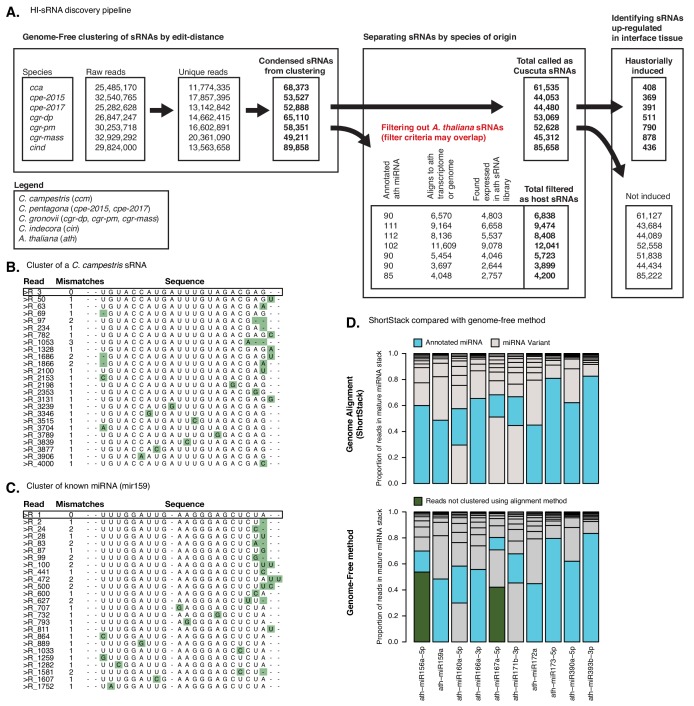
Genome-free HI-sRNA discovery pipeline.(A) Discovery of HI-sRNAs in Cuscuta isolates. Three major steps include condensing reads to representative sRNAs in a genome-free manner, filtering reads which could have originated from A. thaliana, and performing differential expression with DEseq2 to find reads up-regulated in the interface tissue (FDR < 0.1, null hypothesis: sRNA not differentially expressed). (B) Example of a C. campestris sRNA discovered by this method, with the top 25 constituent sRNA sequences ranked by expression. Highest expressed read is deemed as the representative sRNA sequence and is shown with black box. Green boxes show variations from representative sequences with total distance shown to left. (C) Same as B but with a known miRNA, showing similar variation to the novel sRNA in B. (D) Comparing the proportion of reads present in annotated miRNAs, using both genome-alignment (ShortStack) and genome-free based approaches. Reads are ranked by size, with the canonical miRNA (blue) and the variants (grey) showing the proportion of reads they make up in the sRNA. Reads grouped in the locus by the genome-free method that are absent in the alignment approach are shown in green.